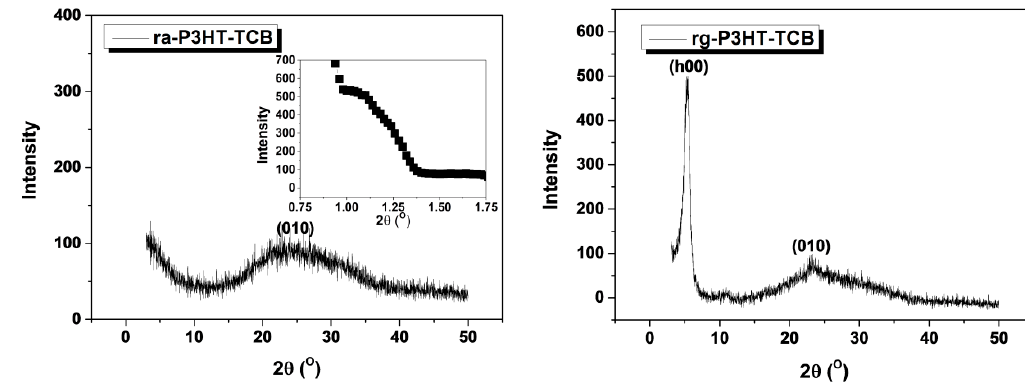
Figure 4. XRD patterns of ra-P3HT-TCB and rg-P3HT-TCB.